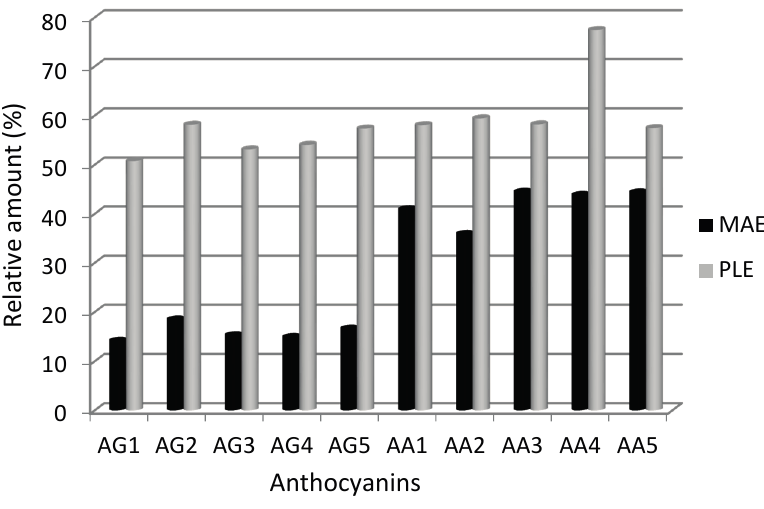
Figure 3. Recoveries of anthocyanins at 125 °C using microwave-assisted extraction and pressurized liquid extraction conditions. AG1–AG5: glycosylated anthocyanins, AA1–AA5 acylated anthocyanin derivatives. See Table 1 for a full identification of anthocyanins.